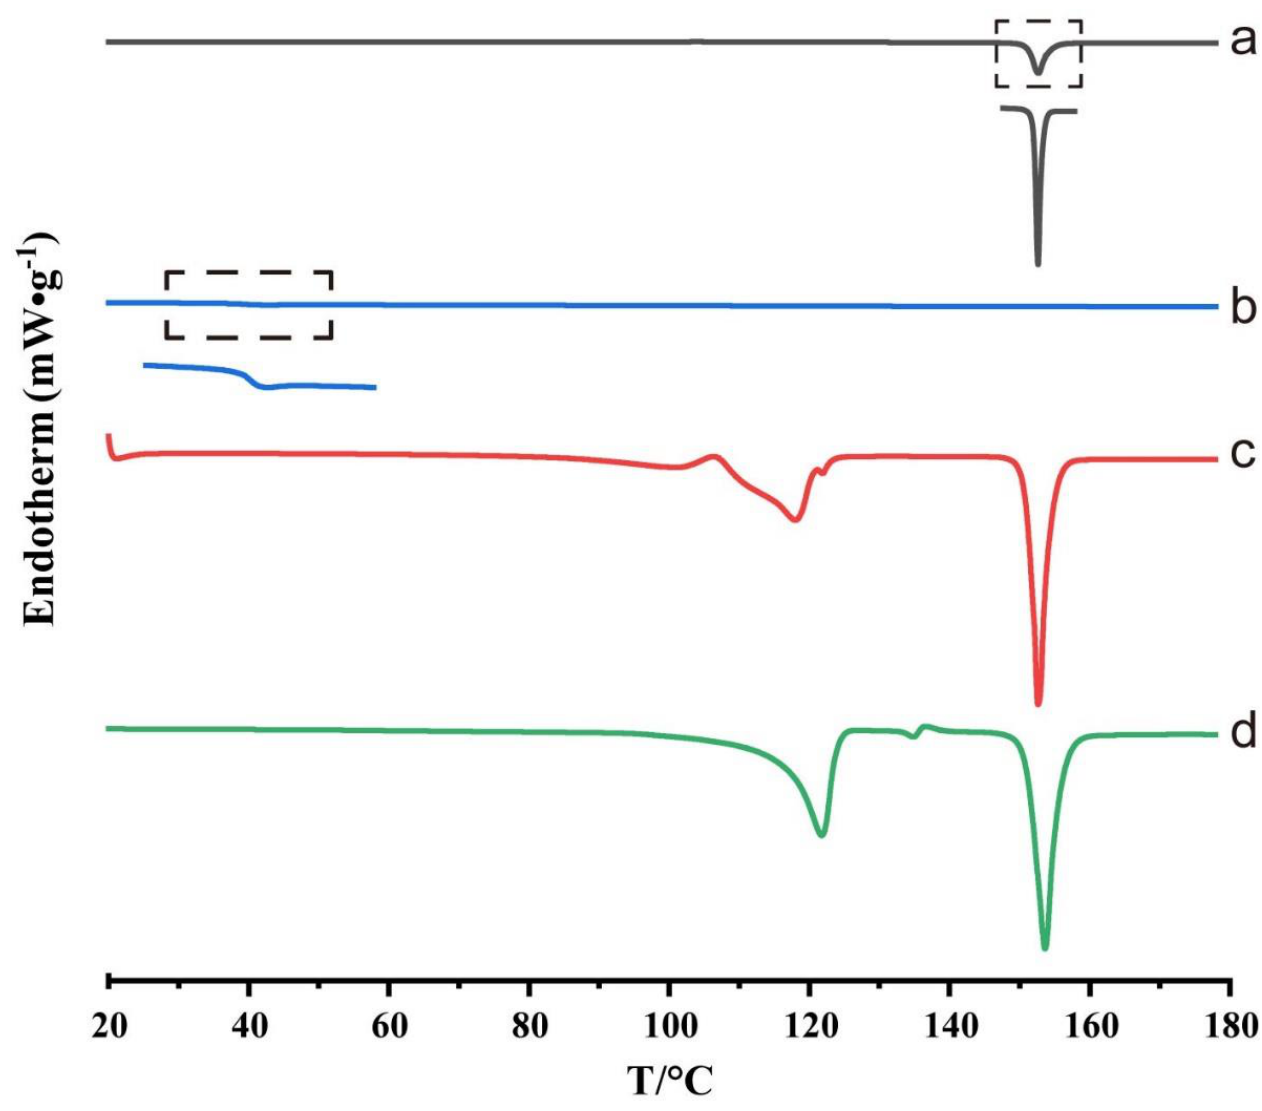
Figure 3. DSC thermograms of ( a ) crystalline ACM, ( b ) amorphous ACM, ( c ) monohydrate ACM and ( d ) ACM gels.